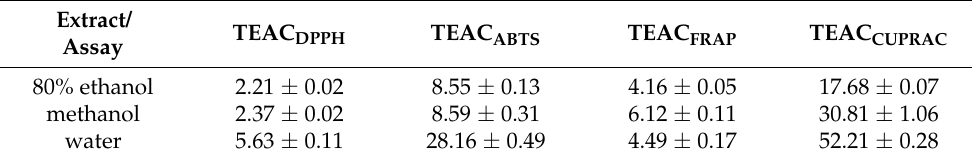
Table 6. In vitro antioxidant activity of T. versicolor NBIMCC 8939 extracts according to DPPH, ABTS, FRAP and CUPRAC ( µ M TE/g